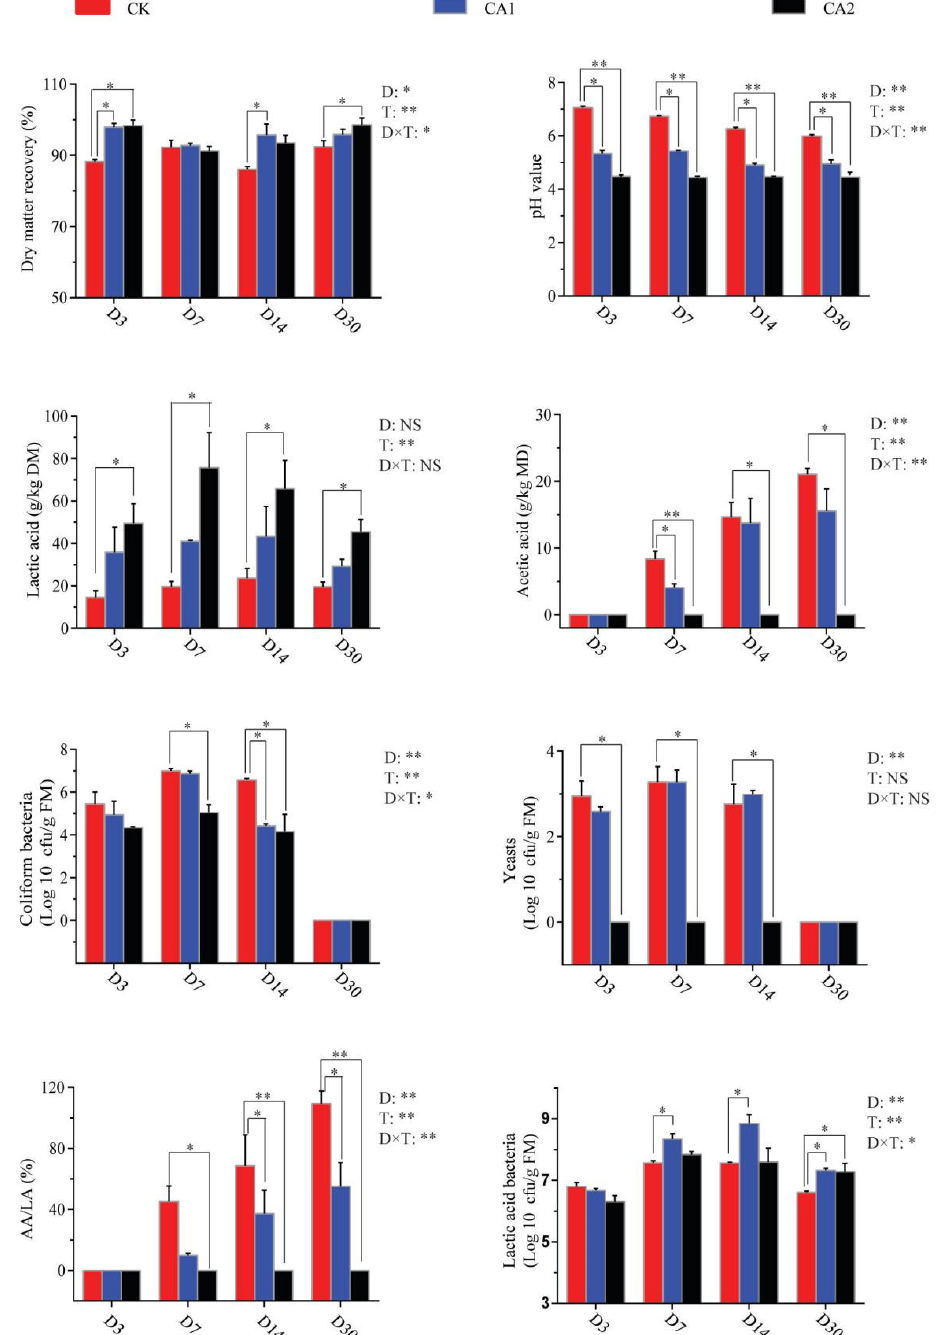
Figure 1. The fermentation parameters and microbial counts of mulberry leaf silages (D, ensiling days; T, treatments; D × T, the interaction of ensiling days and treatments; *, p < 0.05; **, p < 0.01; NS, non-significance; CK, the control; CA1, 1% citric acid; CA2, 2% citric acid; D3, 3 days of ensiling; D7, 7 days of ensiling; D14, 14 days of ensiling; D30, 30 days of ensiling; AA/LA, the ratio of acetic acid to lactic acid; cfu, colony-forming unitS; FM, pre-ensiled material).